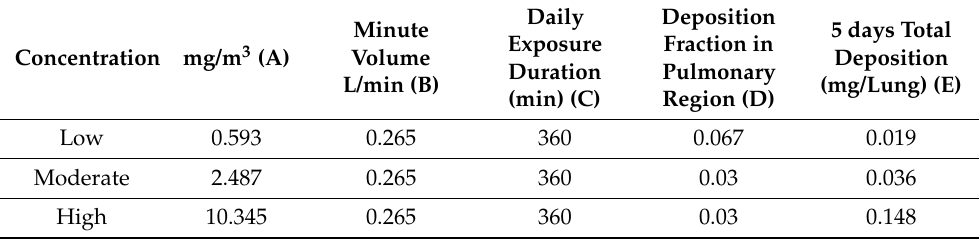
Table 7. Deposition of CNF in the pulmonary region during 5 days inhalation exposure.